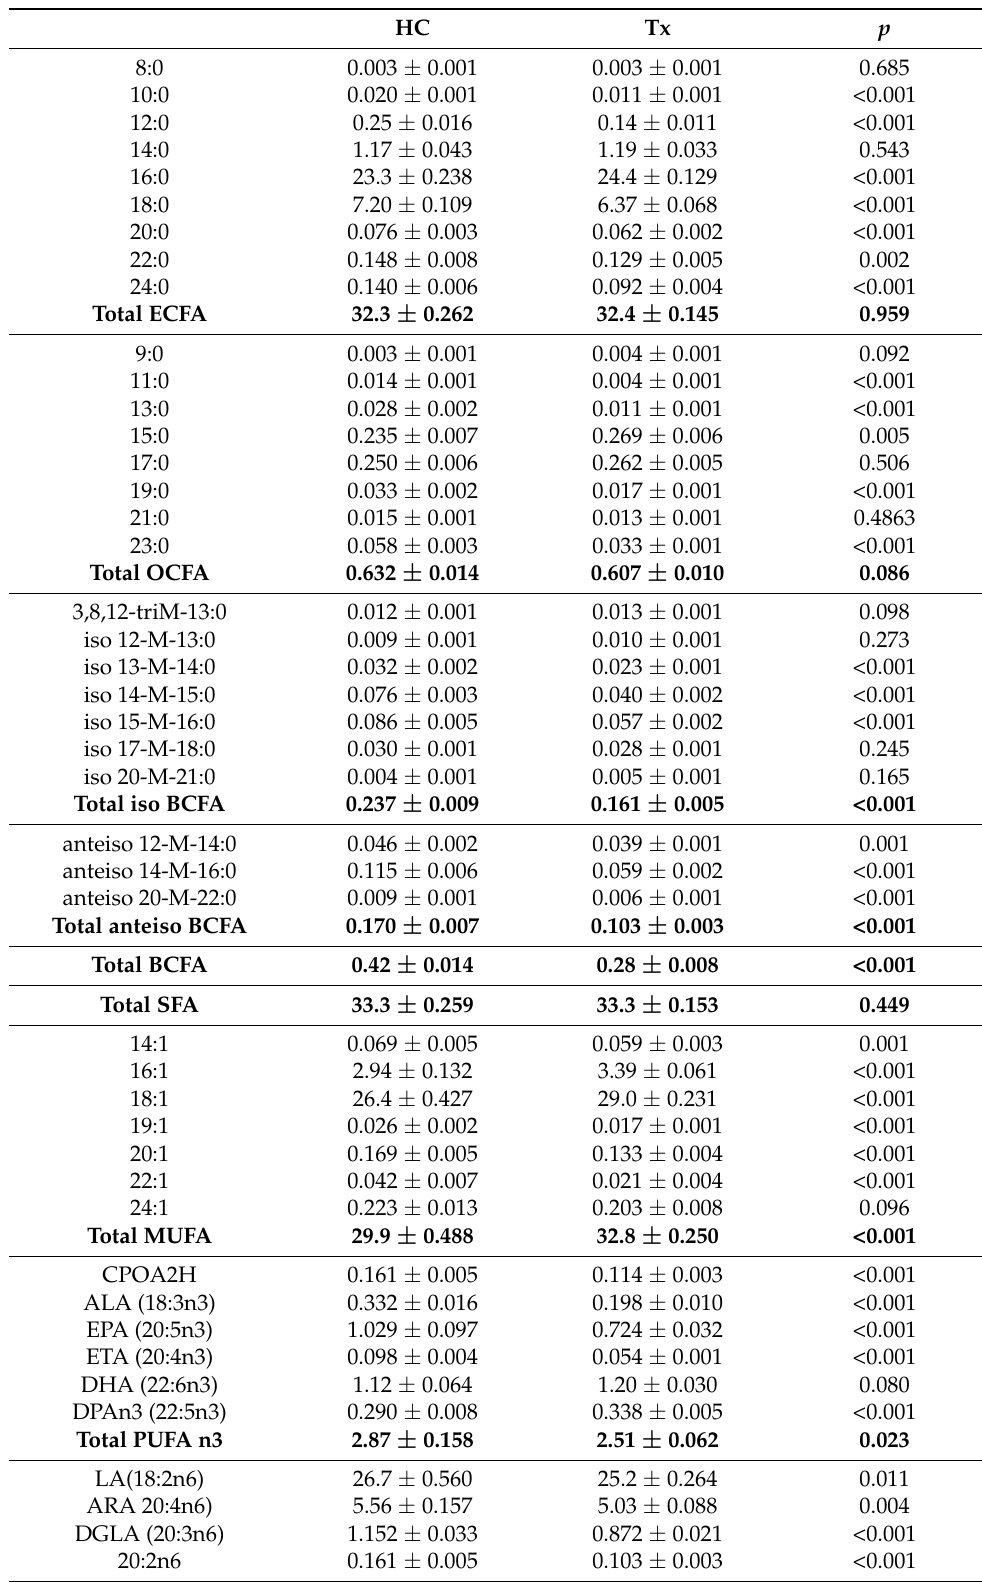
Table 2. Profile of fatty acids (%) in healthy control (HC) and kidney transplant patients (Tx) sera. Values are mean ±